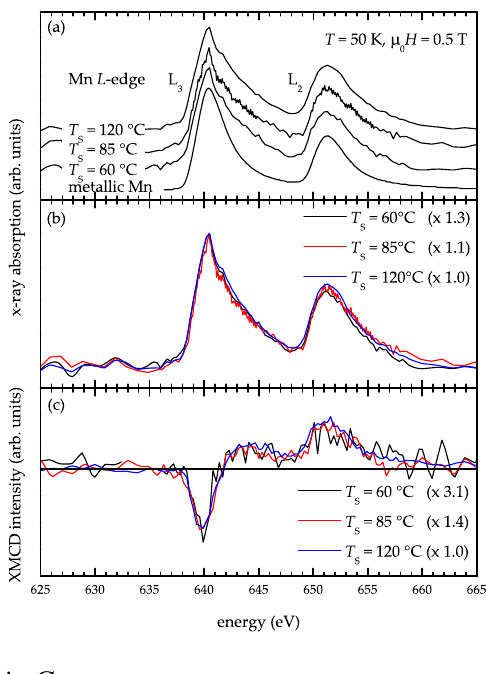
Figure 2 . XA [(a) and (b)] and corresponding XMCD spectra (c) of GeMn thin films measured at 50 K. The total Mn content for all films is 2.8%. For comparison, the absorption spectrum of metallic Mn is included in (a). The XA and XMCD spectra are normalized to the L peak intensity of the thin film grown at 120 ◦ C in [(b) and (c)], respectively. 3 The scaling factors are given in the corresponding insets. (Reprinted with permission from Ref. [30]. Copyright 2009, American Institute of